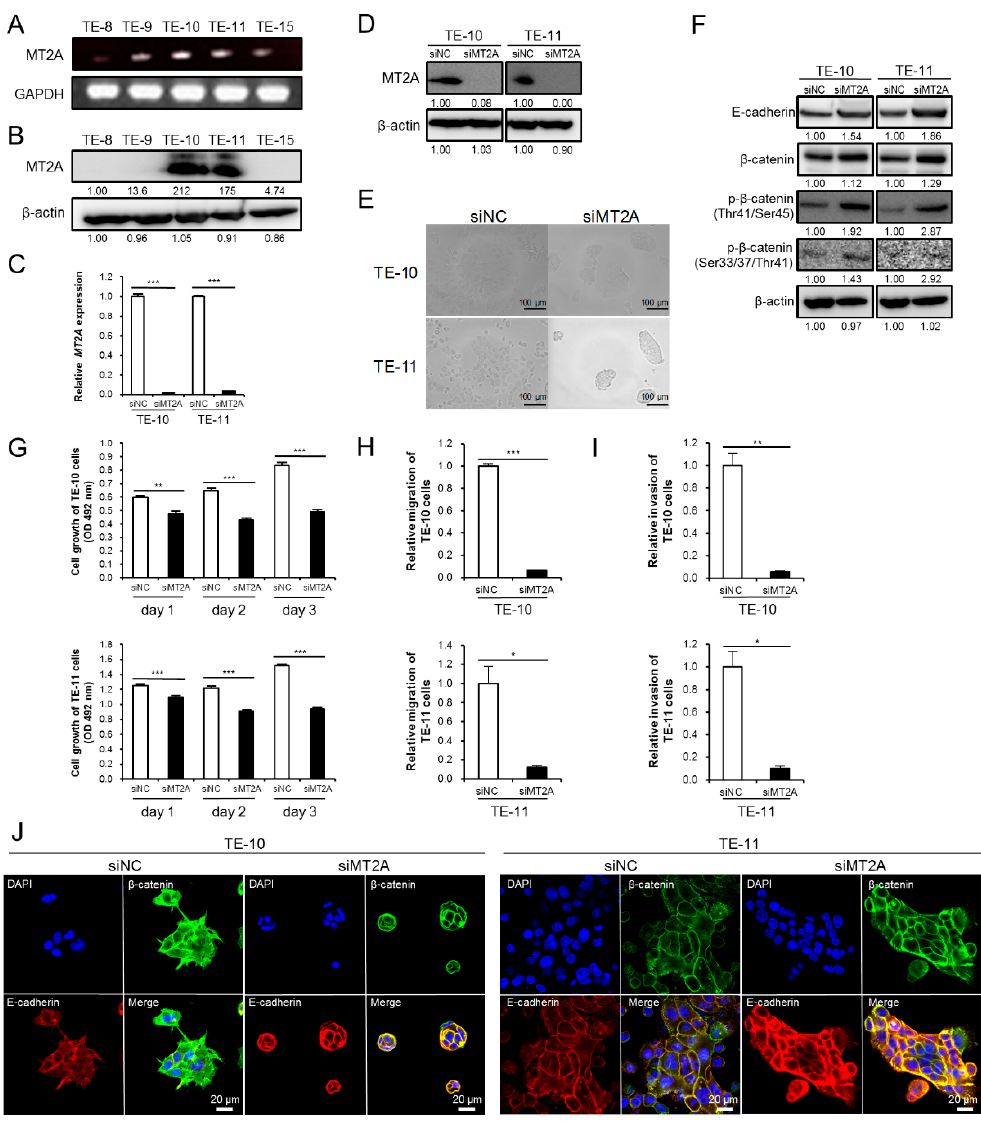
Figure 5. The high expression of MT2A in ESCC cells promoted their growth, migration, and invasiveness, possibly due to the downregulation of E-cadherin. ( A ) Expression of MT2A mRNA in five ESCC cell lines, TE-8, TE-9, TE-10, TE-11, and TE-15, evaluated by RT-PCR. GAPDH was used as the internal control. ( B ) Western blotting to confirm the expression of MT2A protein in the five ESCC cell lines. ( C , D ) TE-10 and TE-11 were transfected with siRNA against MT2A (siMT2A) and control siRNA (siNC). MT2A knockdown was confirmed by qRT-PCR ( C ) and Western blotting ( D ) in TE-10 and TE-11. After Western blotting, the normalized relative expression fold-change was calculated using the ImageJ software, and the values were arbitrarily set as 1.00 for the cells transfected with siNC. ( E ) Changes in the cell morphology of ESCC cell lines transfected with siNC or siMT2A under a phase contrast microscope. ( F ) Western blotting for expression levels of E-cadherin and phosphorylation levels of β -catenin in siMT2A-treated TE-10 and TE-11 cells, compared with those in cells treated with siNC. The normalized relative expression fold-change was calculated using the ImageJ software, and the values were arbitrarily set as 1.00 for cells transfected with siNC. ( G ) MTS assay for cell growth in TE-10 and TE-11 cells treated with siMT2A or siNC. Each ESCC cell line transfected with siNC and siMT2A was seeded in 96-well plates at 5 × 10 3 cells per well with RPMI-1640 + 1% FBS. The cell growth was evaluated after 24, 48, and 72 h. ( H , I ) Transwell migration ( H ) and invasion ( I ) assay of ESCC cell lines transfected with siNC and siMT2A. ( J ) Double immunofluorescence was performed using anti- β -catenin (green) and anti-E-cadherin (red) antibodies in the ESCC cell lines transfected with siNC and siMT2A. Cell nuclei were stained with DAPI (blue). Data are presented as mean ± SEM (* p < 0.05, ** p < 0.01, *** p < 0.001).